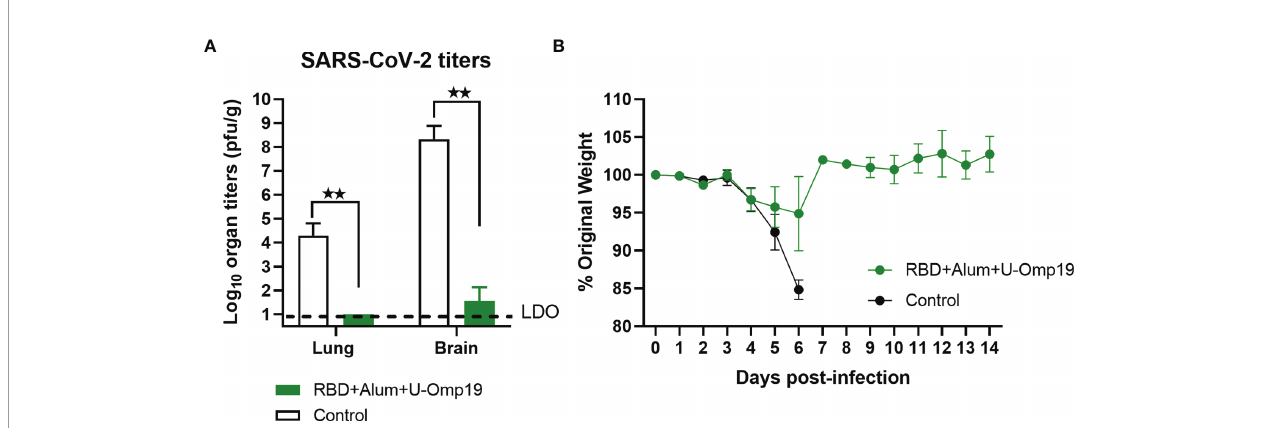
FIGURE 9 | Vaccination with RBD+Alum+U-Omp19 protects K18-hACE2 transgenic mice against SARS-CoV-2 infection. Mice received PBS (Control) (n = 7) or RBD+Alum+U-Omp19 (n = 8) administered via i.m. route at days 0 and 14. Mice in each group included similar number of males and females. Four weeks following immunization, K18-hACE2 mice were intranasally infected with 2 × 10 5 PFU of SARS-CoV-2. (A) Five days after infection, lungs and brains (n=3) were obtained from groups of mice, and SARS-CoV-2 virus was titrated. Bars represent the mean ± SEM. Dotted line: limit of detection (LOD). **p < 0.01. t-test. (B) Weight loss outcomes in K18-hACE2 transgenic mice vaccinated and challenge with SARS-CoV-2. Weight changes in mice were monitored daily until day 14 after infection. Points are means ± SEM of percentage of original